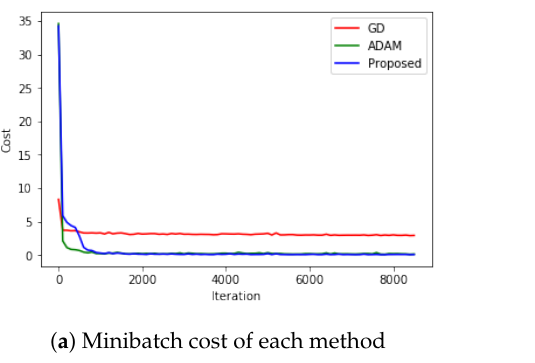
Figure 13. Comparing the proposed scheme with other schemes.